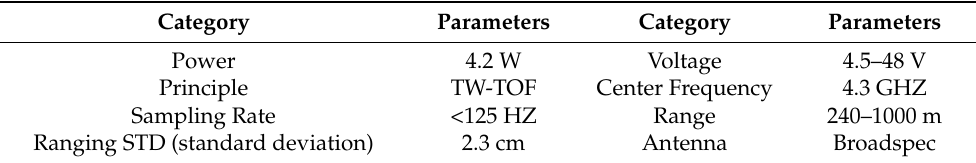
Table 2. The main parameters of PulsON.